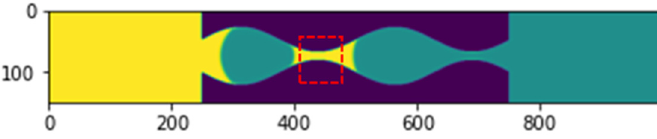
Figure 13. The snap-off phenomenon.